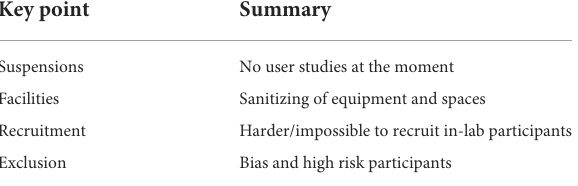
TABLE 6 COVID-19